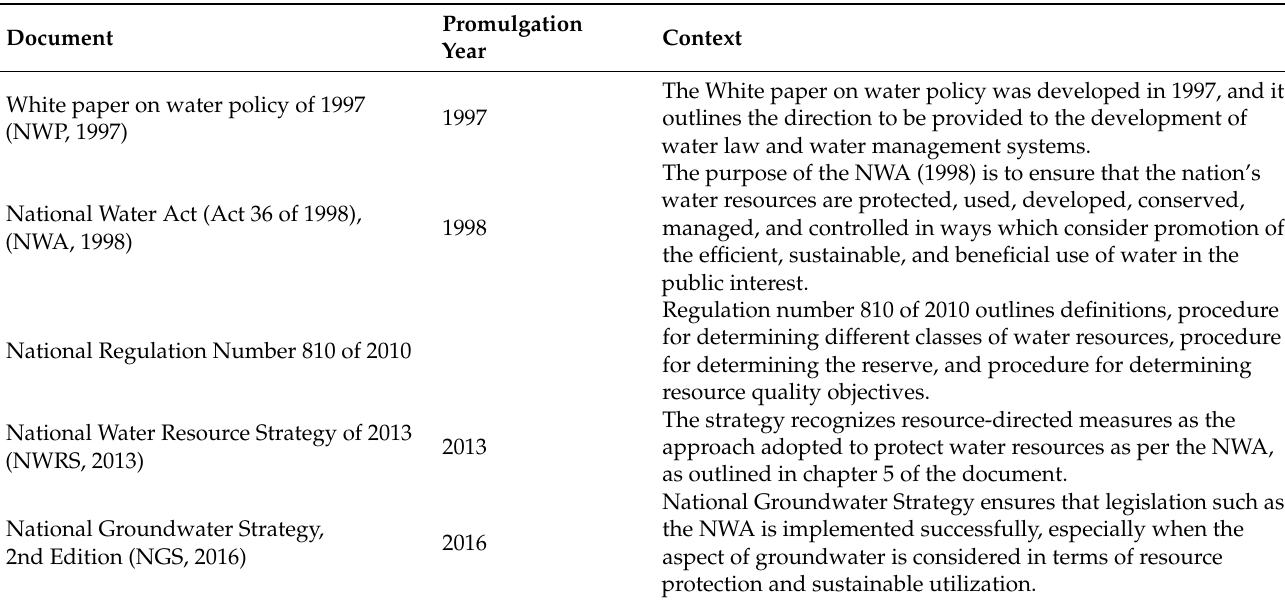
Table 1. Illustration of key policy documents on water resources protection in South